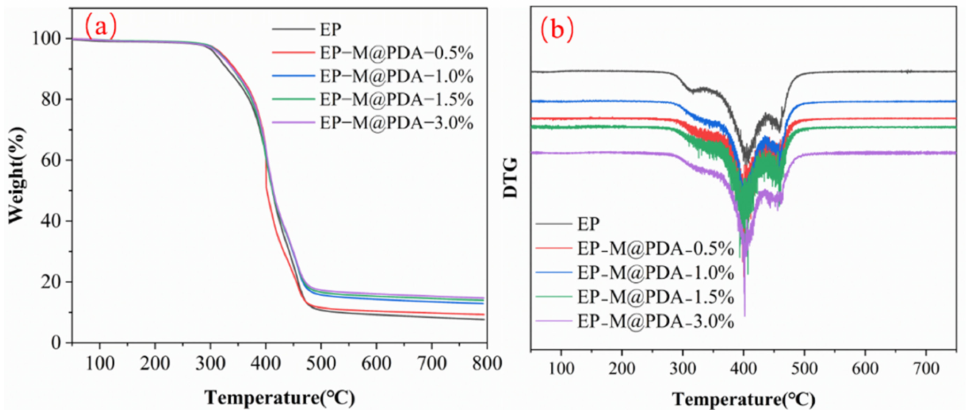
Figure 6. ( a ) Thermogravimetric analysis of the MWCNTs@PDA epoxy composites. ( b ) Derivative